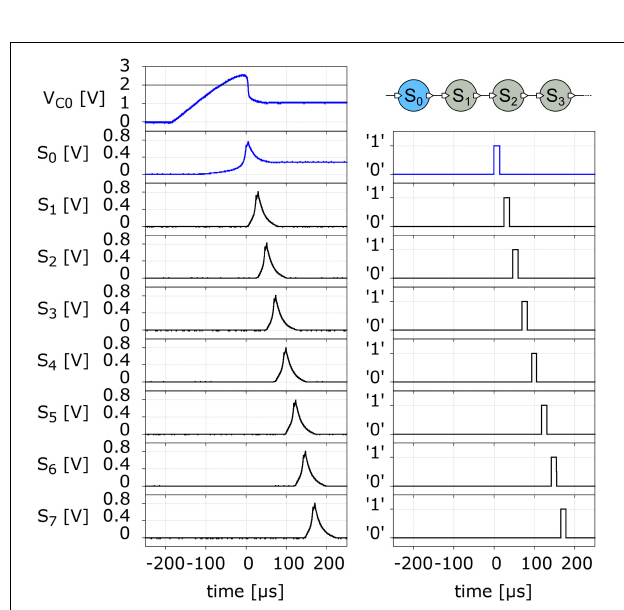
FIGURE 5 | Left panels: Measured action potential spike signal propagating along a 7-segment long-axon neuron (top right panel) . The top left panel V C 0 has the voltage on the membrane capacitor C (see Figure 4 ). The signals S 0 to S 7 correspond to the action potential spike voltage measured on the resistor R 3 at the exit of the SCR (see Figure 4 ). The corresponding panels on the right have the output of the respective neurons. The logic “0” corresponds to a physical voltage value of 5 V, and the “1” to 0